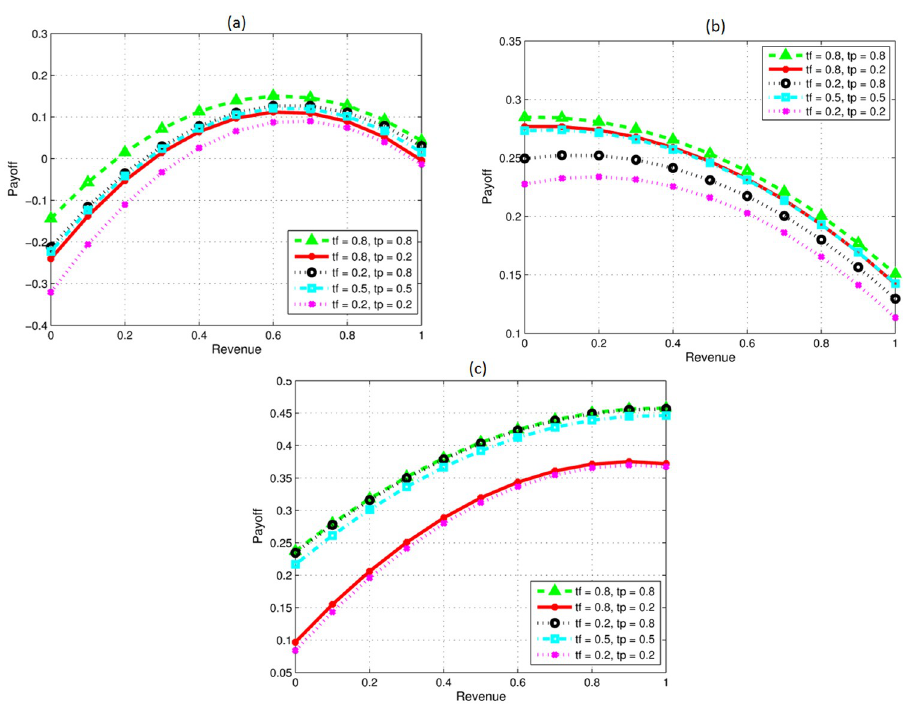
Fig 4. Impact of trust level. (a) Varying trust only. (b) P high knowledge investment, F high technical skills. (c) Trust varying, P high knowledge investment and high technical